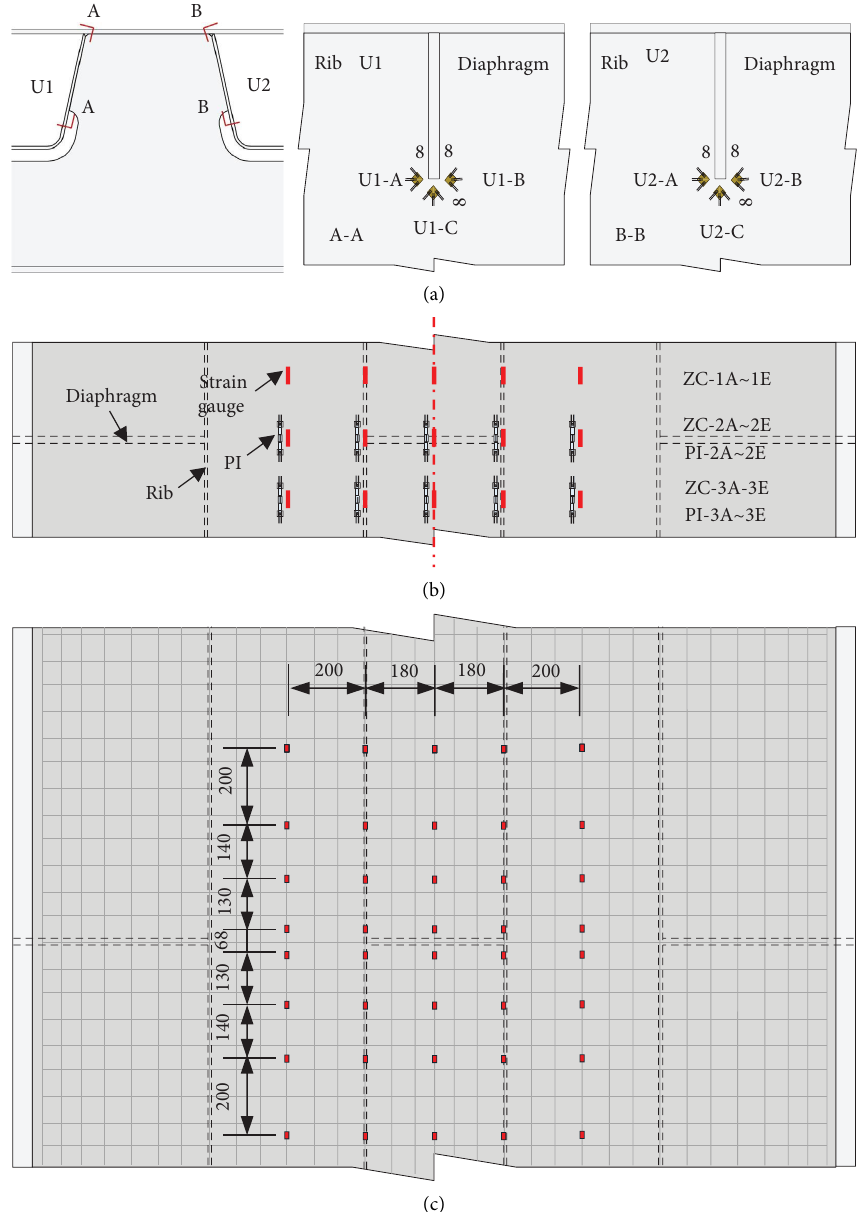
Figure 8: Instrumentation of longitudinal specimen (unit: mm): (a) strain of rib-to-diaphragm joint; (b) UHPC strain, and (c) rebar